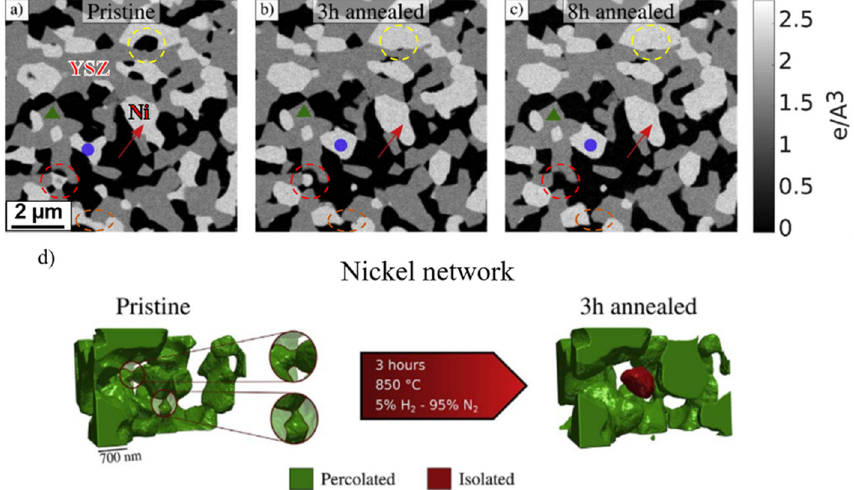
Figure 4. Two-dimensional slices from a spatially registered sub-dataset at identical locations in the electrode in the pristine ( a ), annealed for 3 h ( b ) and 8 h ( c ) states. Three different grey levels are present: black (pore), grey (YSZ), and white (nickel). ( d ) The nickel particle morphology at the same position before and after the annealing (in dry hydrogen at 850 °C). Reproduced with permission from Ref [40].